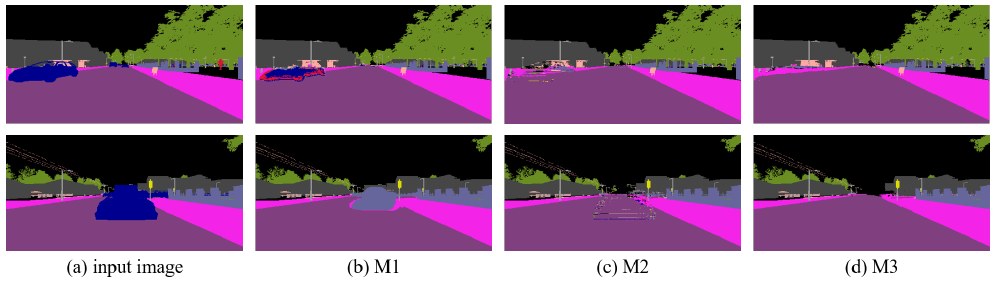
Figure 4. Dynamic removal results under different settings of the model: ( a ) Input Image; ( b ) M1: L CE ; ( c ) M2: L CE + L GAN + L SE ; ( d ) M3: L CE + L GAN + L SE + L TV